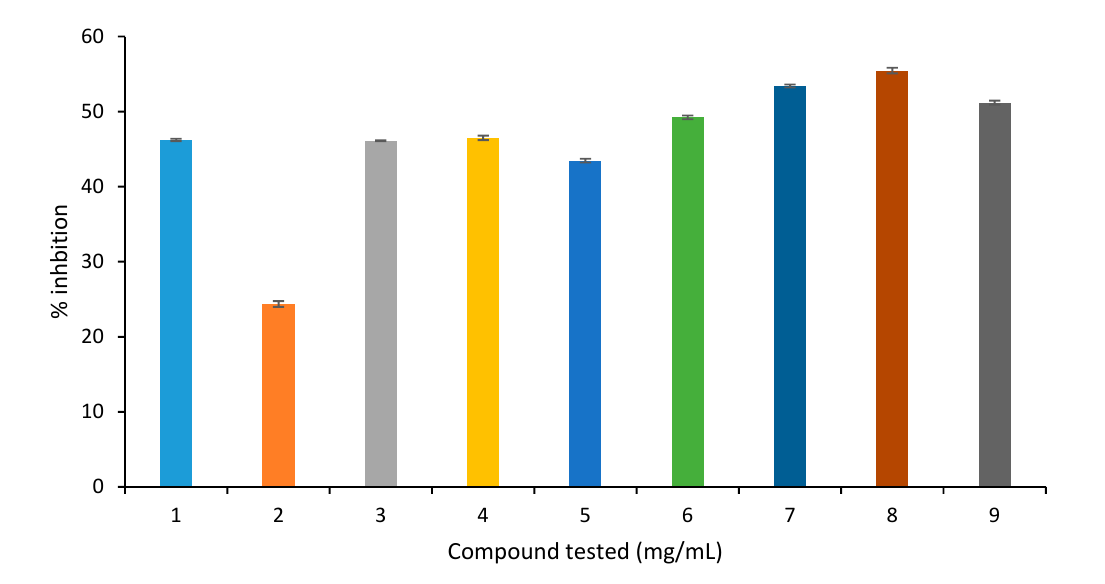
Figure 7. Inhibition of protein cross-link formation in the BSA-glucose assay (1 = eugenol, 2 = caryophyllene, 3 = caryophyllene oxide, 4 = α -humulene, 5 = juglone, 6 = 2-phenylethylisothiocyanate, 7 = quercetin, 8 = quercitrin, 9 = apigenin).